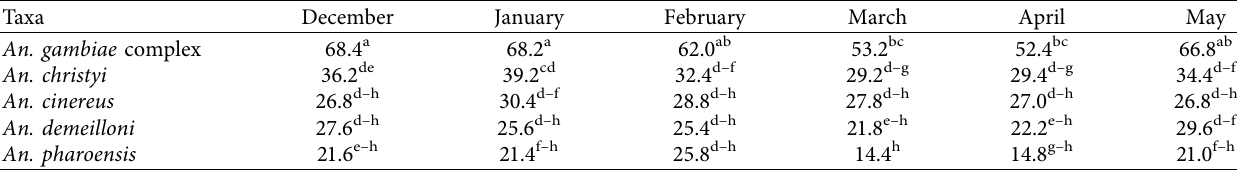
Table 2: Mean of the number of larvae in months of the study season.